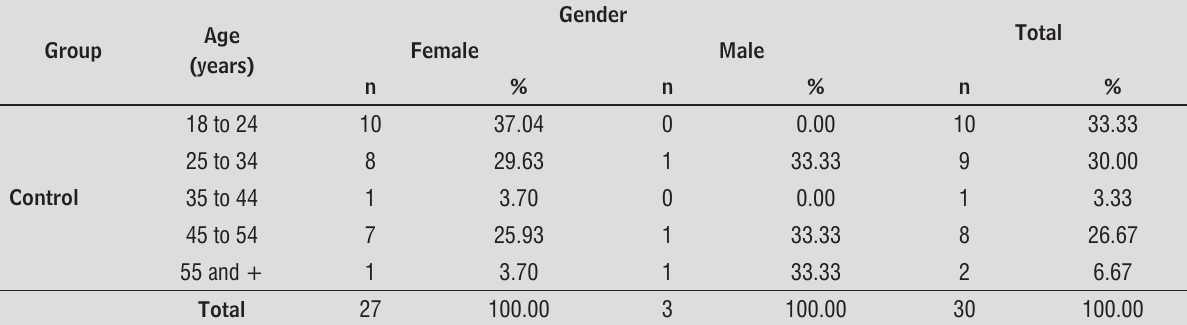
Table 2 - Distribution of the individuals with Temporomandibular Disorders, according to gender and age group in the group that received dental treatment only, Ribeirão Preto - SP, 2008 Group